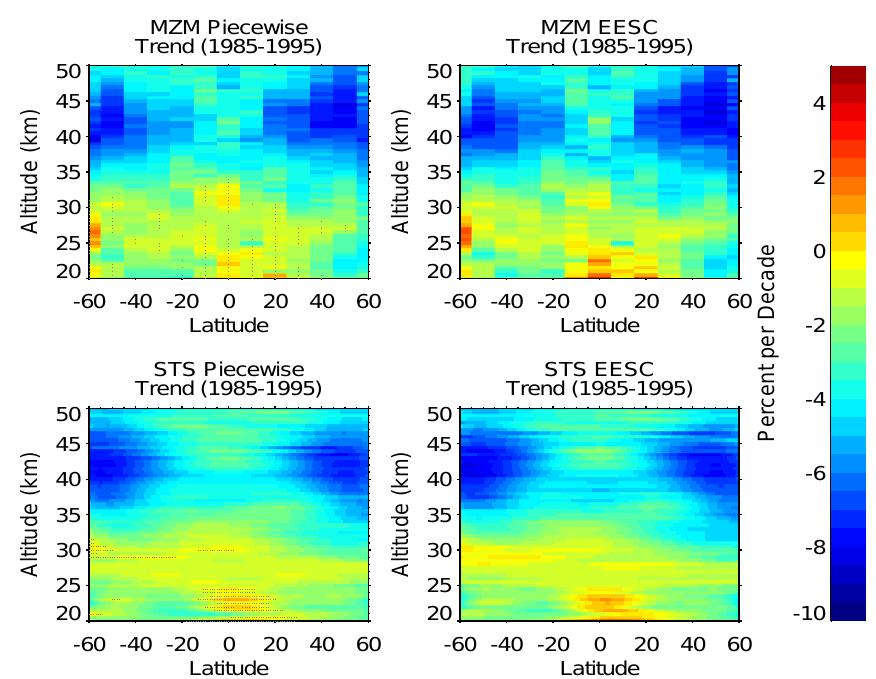
Figure 14. Mean trend between 1985 and 1995 for four analysis scenarios computed as (Tr(1995) − Tr(1985)) / Tr(1985) · 100, where Tr( t ) represents the value of the long-term trend term at time t . The analysis was run for both the MZM and STS regression methods, each using either a piecewise linear term joined at 1997.0 or two orthogonal EESC terms. Stippling shows regions where the linear slope is not significant at the 2 σ level. No similar calculation can be done for multiple EESC